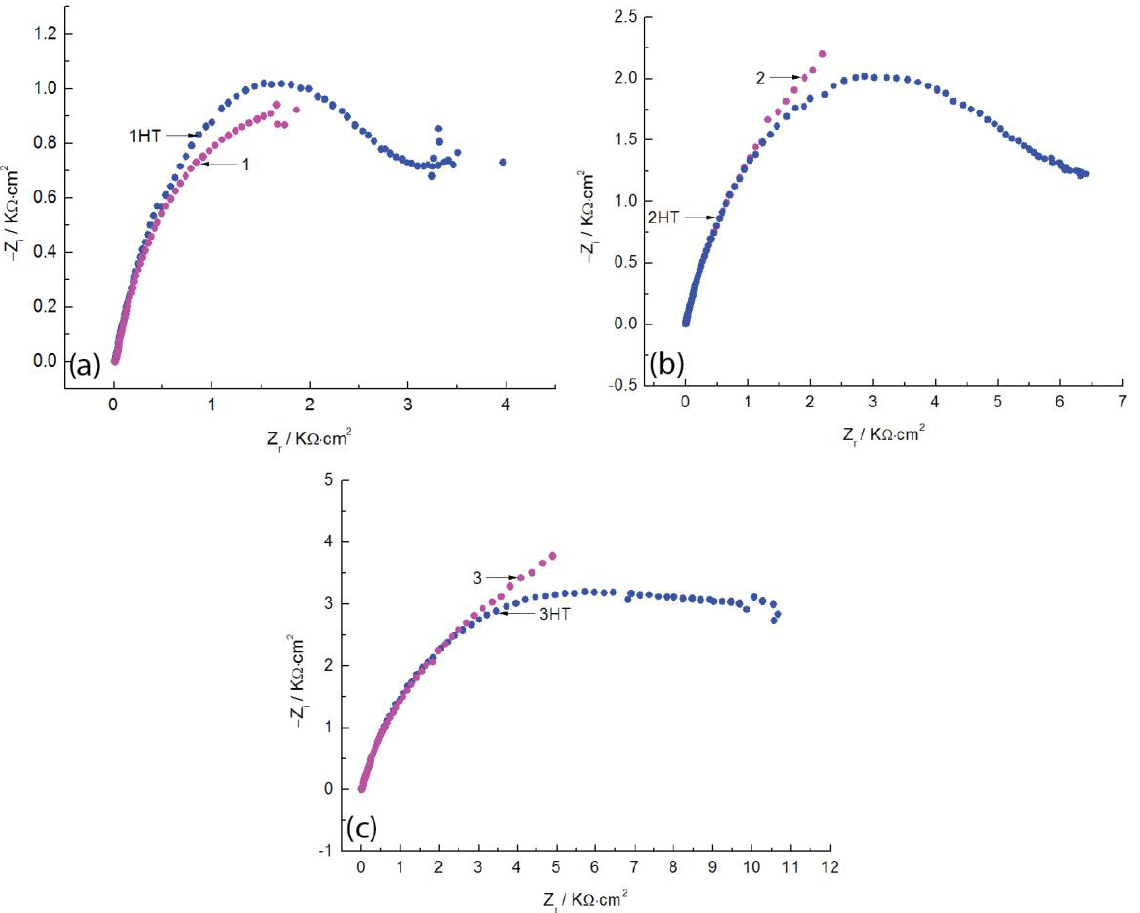
Figure 5. Nyquist plots obtained for the samples: ( a ) 1, 1HT; ( b ) 2, 2HT; ( c ) 3, 3HT.